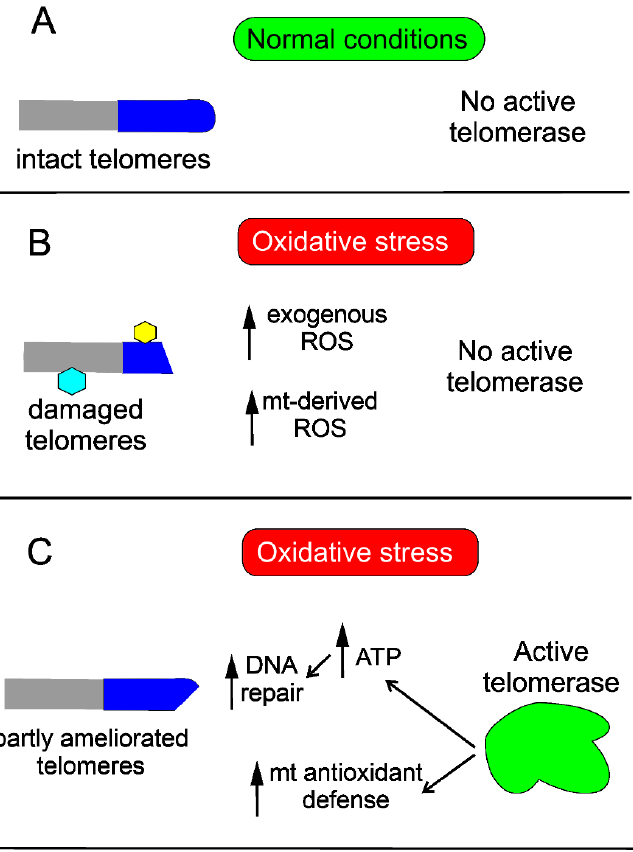
Figure 3. Telomerase improves telomeres damaged in oxidative stress. Telomeres (dark blue cap), intact in normal conditions ( A ), may be damaged in oxidative stress ( B ), which leads to stress-induced senescence. Damage to telomeres is presented as their shortening and modification (hexagons), also affecting the non-telomeric part of chromosomes (grey). Oxidative stress may be of endogenous and/or exogenous origin and is associated with reactive oxygen species